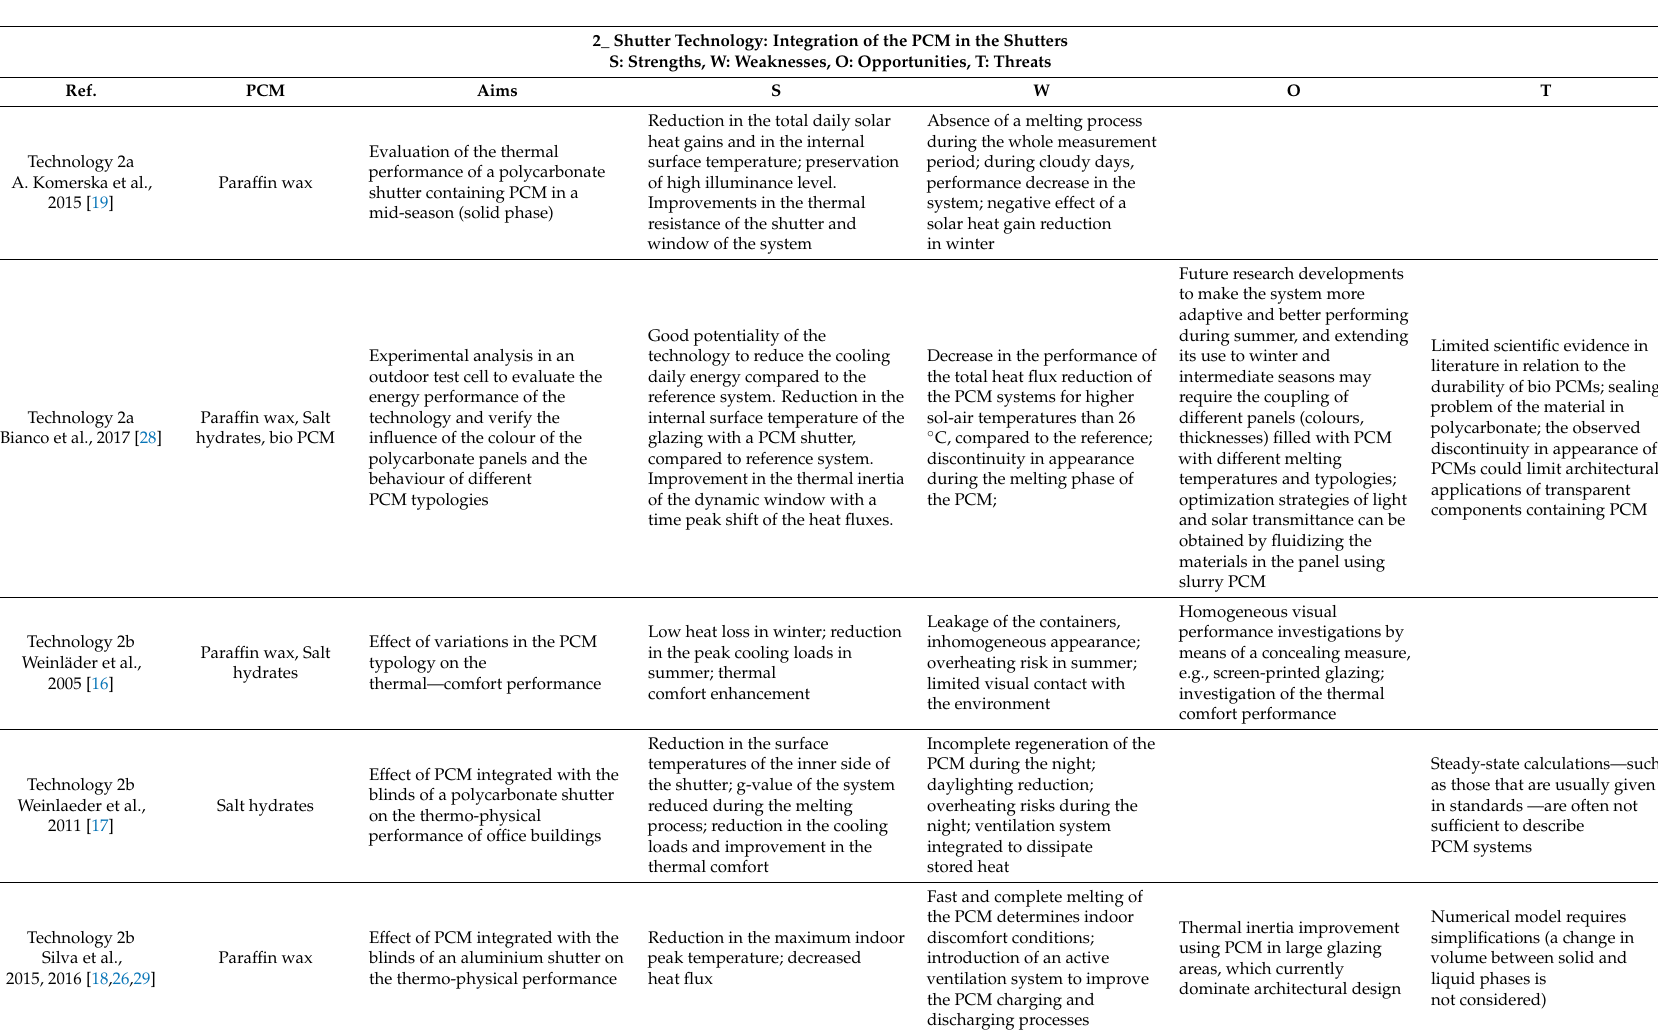
Table 4. SWOT analysis of PCM in